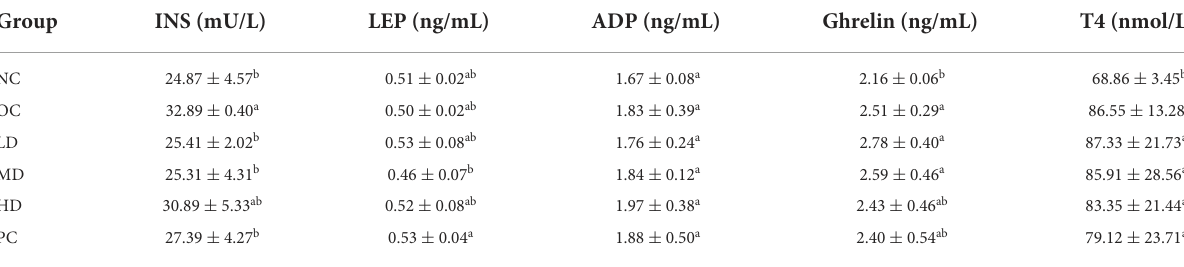
TABLE 2 Effects of raw plantain flour on serum hormones of obese rats. Group